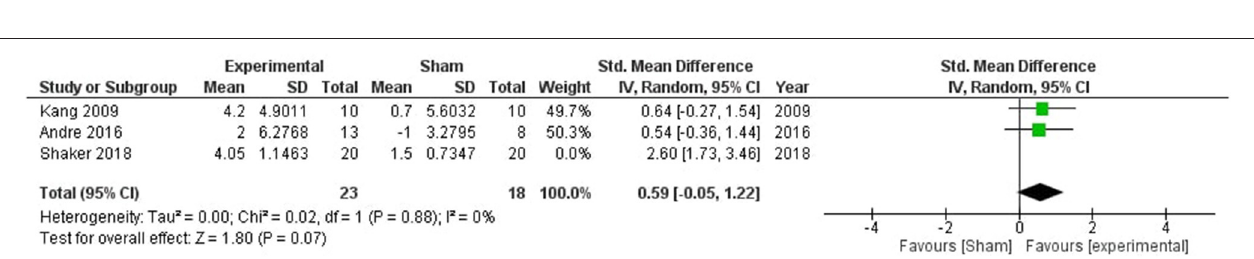
FIGURE 2 | Comparison of the effects of active transcranial stimulation and sham stimulation interventions on global cognition. The results did not provide evidence for tDCS efficacy in promoting global cognition (SMD = 0.05; 95% CI = − 0.37–0.46; p = 0.83).